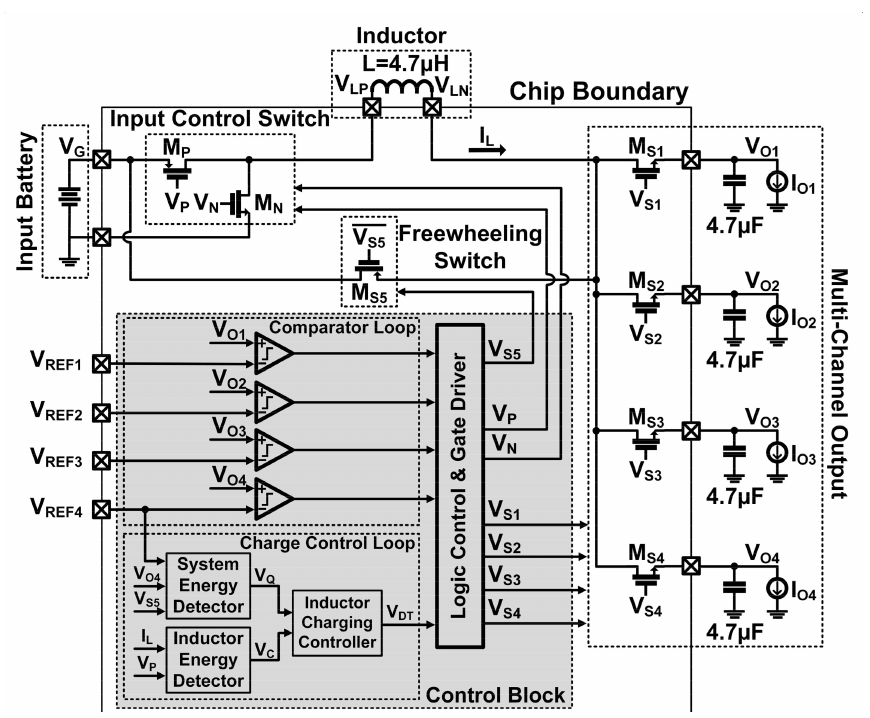
Figure 2. Overall architecture of the hybrid control SIMO buck